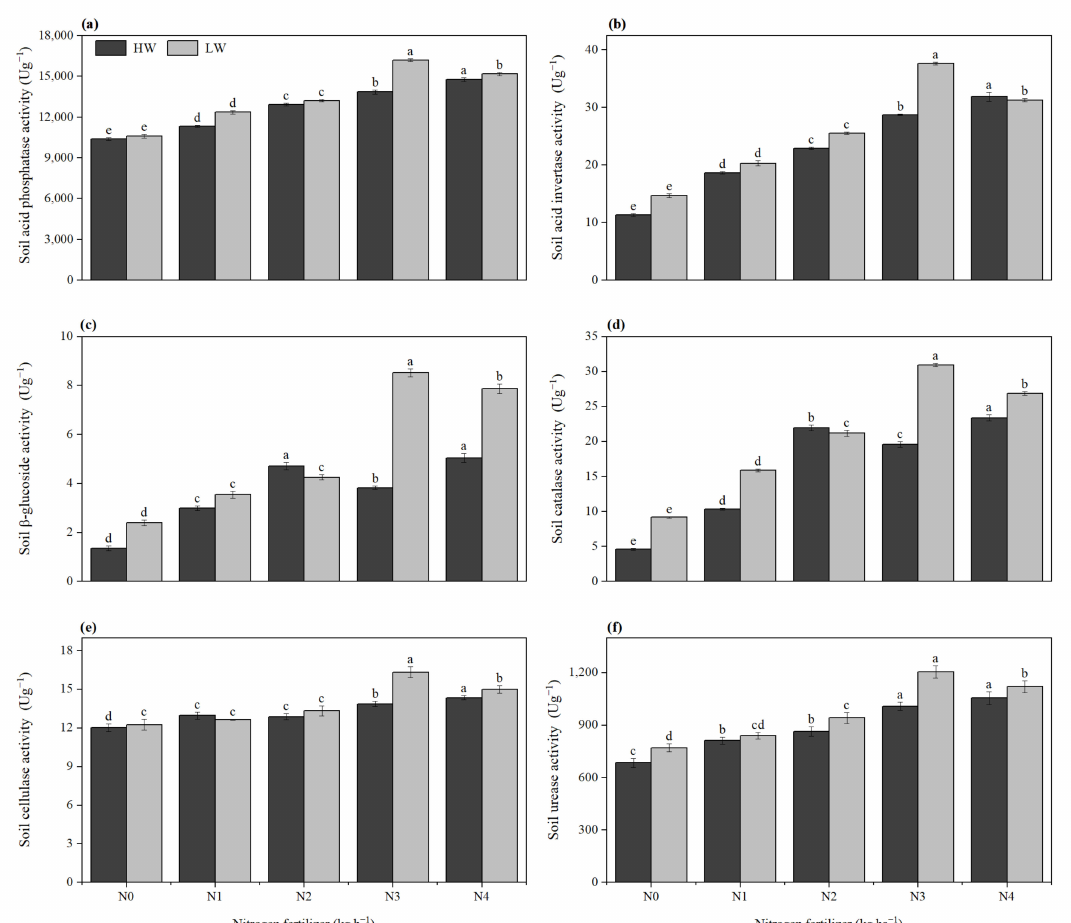
Figure 6. Effects of irrigation and nitrogen rates on soil acid phosphatase ( a ), soil acid invertase ( b ), β -glucosides ( c ), catalase ( d ), cellulose ( e ), and soil urease ( f ). HW and LW represent irrigation water at the rate of 80 and 60% of field capacity. Means followed by different lowercase letters within each treatment indicate significant differences ( p < 0.05). Bars represent the standard errors. The nitrogen treatments N0, N1, N2, N3 and N4 represent the application of nitrogen at the rates of 0, 200, 250, 300 and 350 kg ha − 1